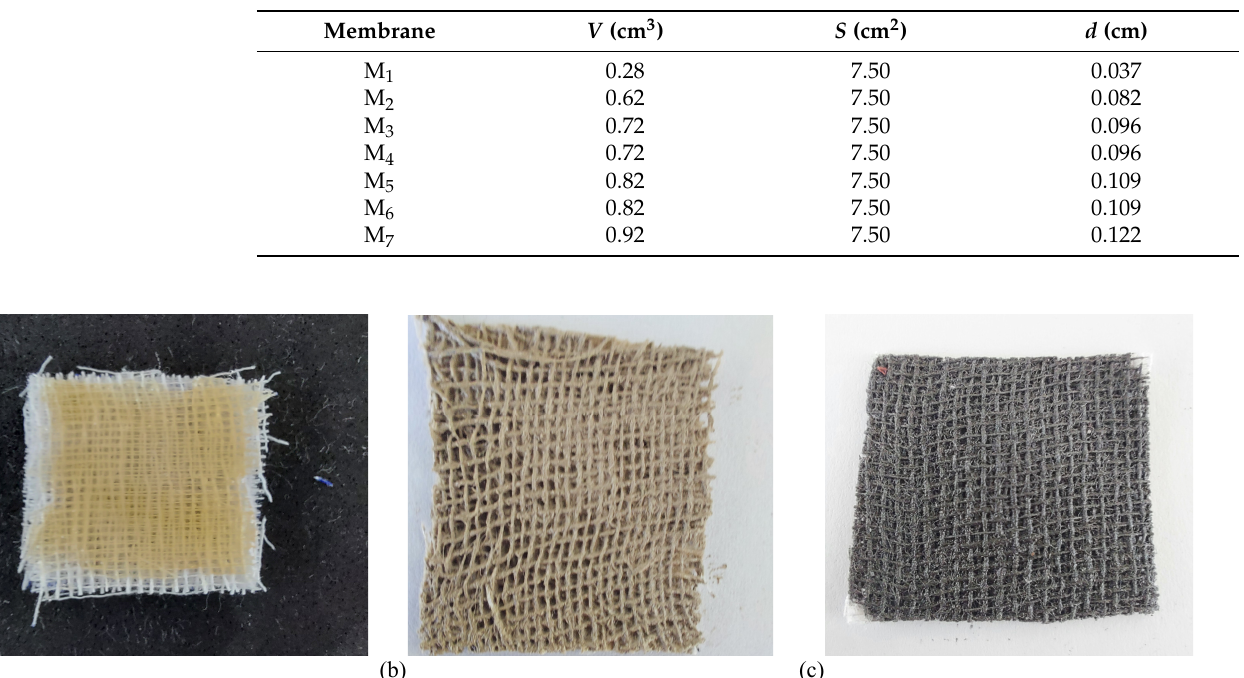
Figure 2. Images of membranes: ( a ) M 2 , i.e., only with honey, ( b ) M 3 , i.e., with honey and silver microparticles, and ( c ) M 4 , i.e., with honey and CI microparticles. The dimensions of all membranes are the same at 30 mm × 25 mm (see text for details). Membrane M 1 is shown in Figure 1b. The other membranes (M 5 , M 6 , and M 7 ) are similar to M 4